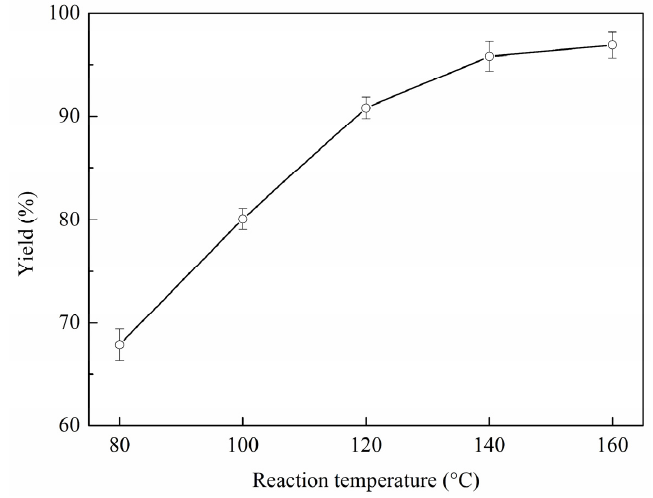
Figure 5. Effect of reaction temperature on the transesterification at reaction time of 3 h and methanol/oil/IL (molar ratio) of 9/1/0.25.